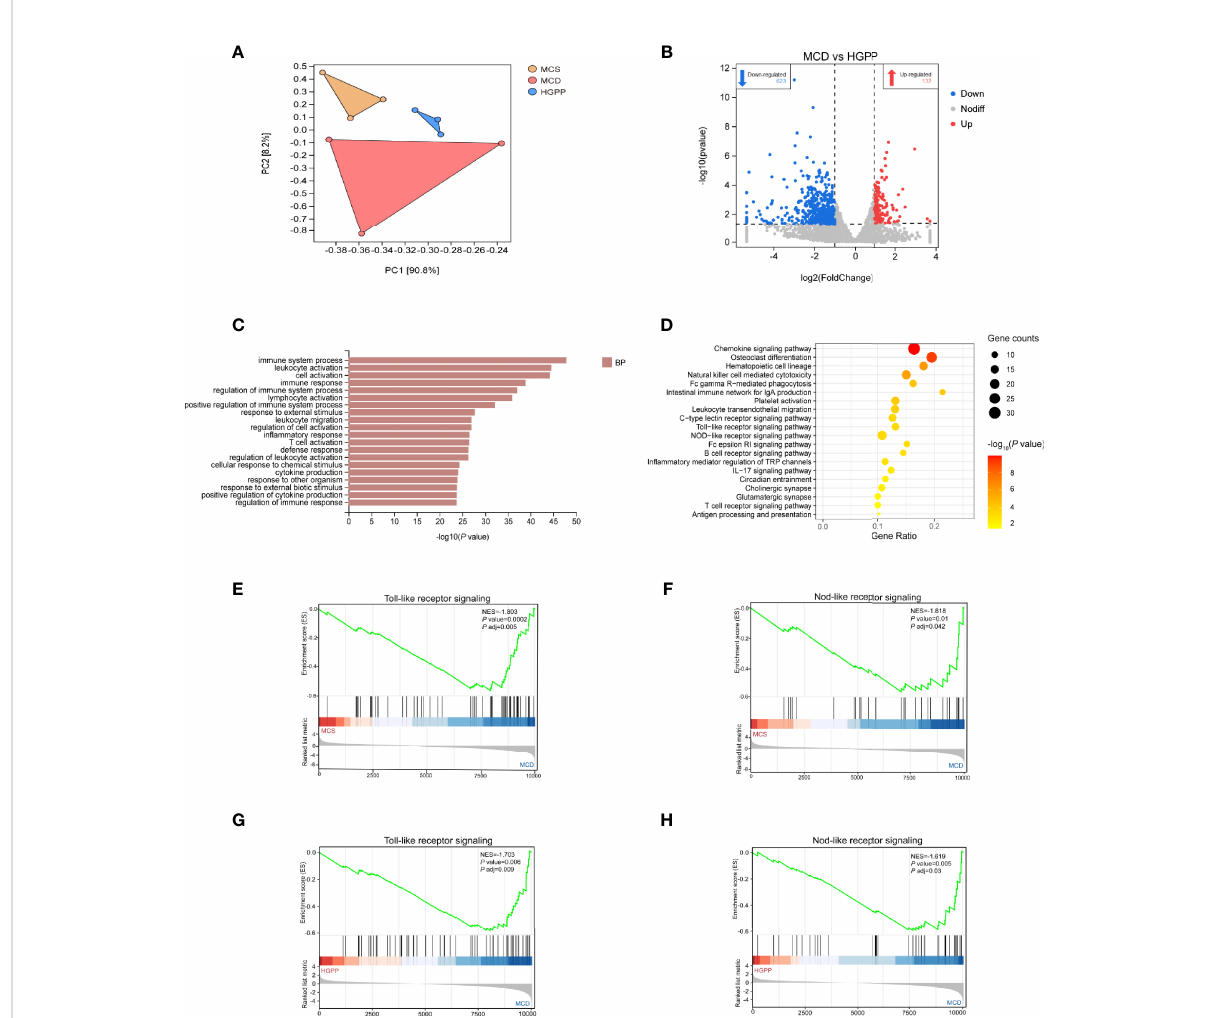
FIGURE 4 HGPP caused a shift in gene expression in mice liver (n = 3). (A) Principal component analysis (PCA) of transcriptional pro fi ling of the mouse liver tissues among three groups. (B) Screening different genes by volcano plot (|log 2 Foldchange|>1, P value <0.05) between MCD vs. HGPP group. (C) Gene Ontology (GO) pathway enrichment analysis of top 20 pathways between the MCD and HGPP groups. (D) Kyoto Encyclopedia of Genes and Genomes (KEGG) pathway enrichment analysis of top 20 pathways between the MCD and HGPP groups. (E) Gene Set Enrichment Analysis (GSEA) of toll-like receptor (TLR) signaling between the MCS and MCD groups. (F) GSEA of nod-like receptor (NLR) signaling between the MCS and MCD groups. (G) GSEA of TLR signaling between the MCD and HGPP groups. (H) GSEA of NLR signaling between the MCD and HGPP